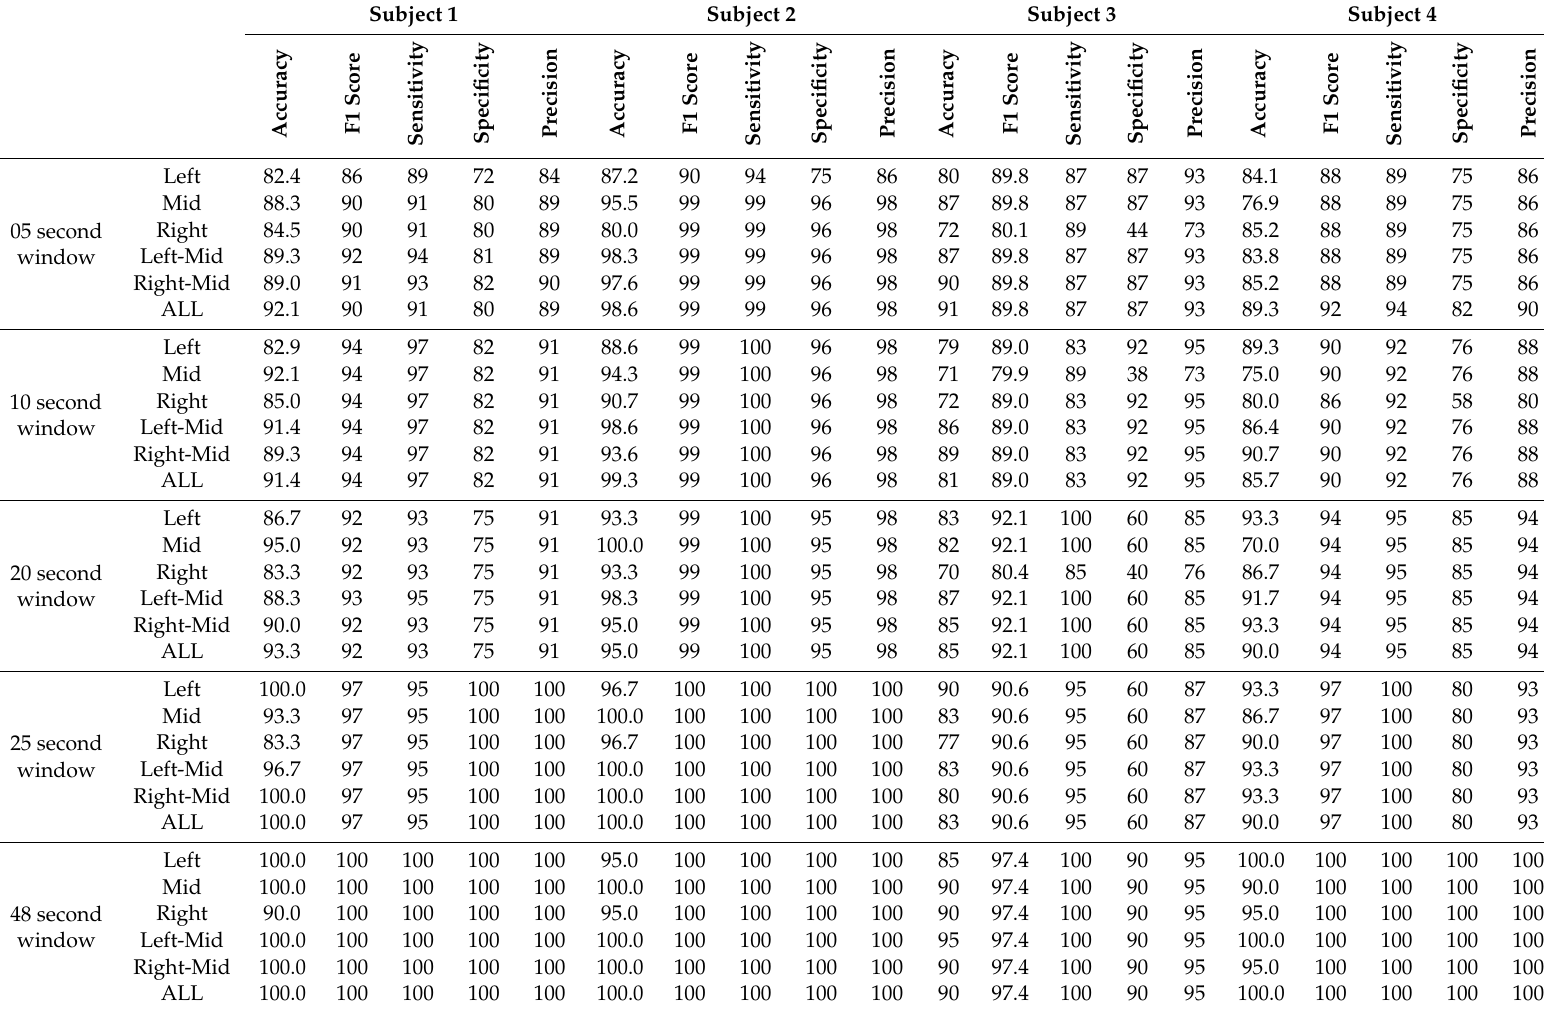
Table A1. Details of Classifiers ( Subjects